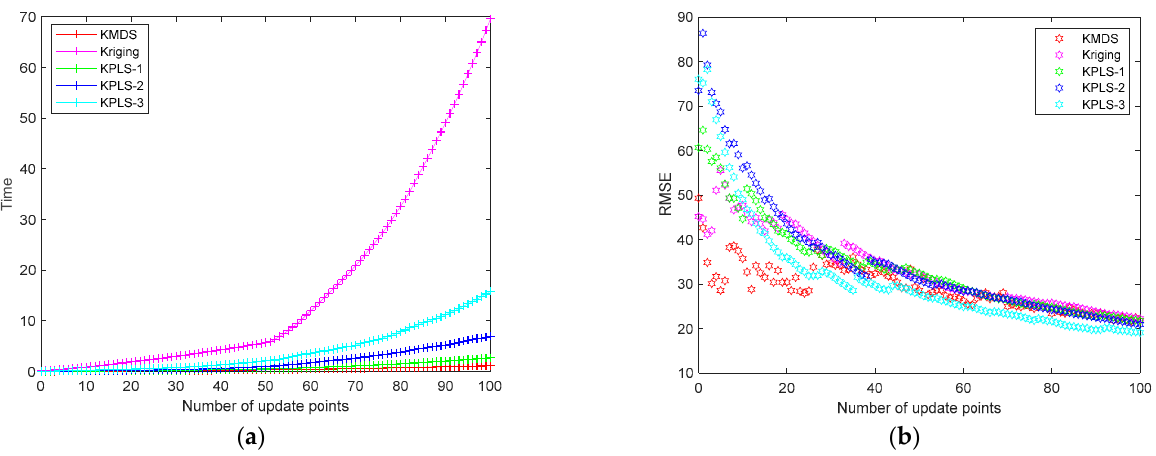
Figure 4. ( a ) The average change trend for the modeling time for the 70D Griewank. ( b ) The average change trend for RMSE for the 70D Griewank. The red and blue curves in Figures 5 and 6 are error bar graphs for the ten test results.